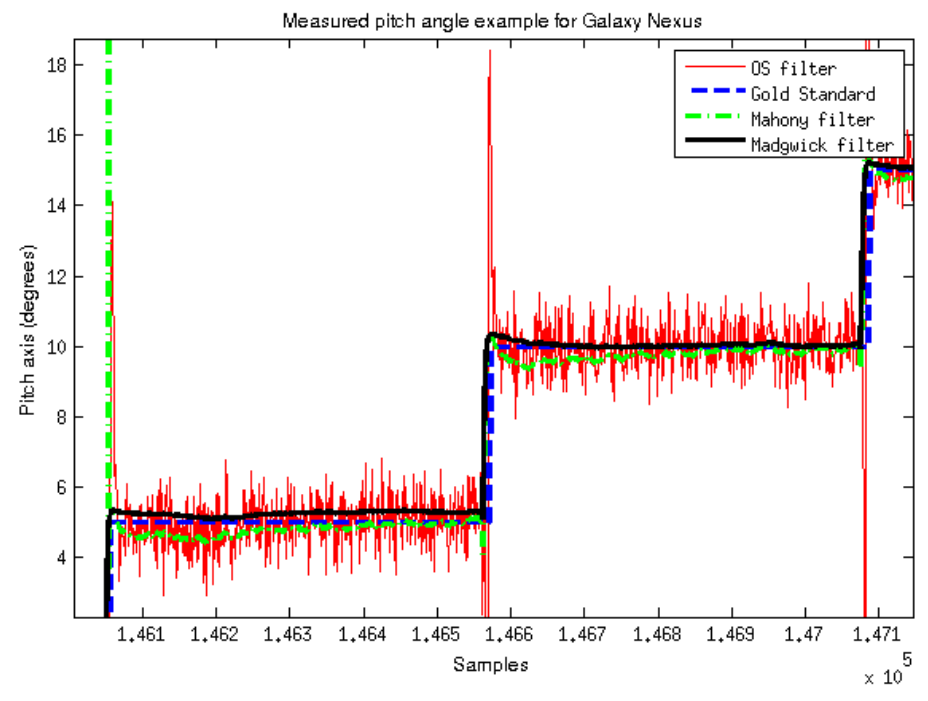
Figure 4. Signals measured during the static protocol for the second and the third targeted